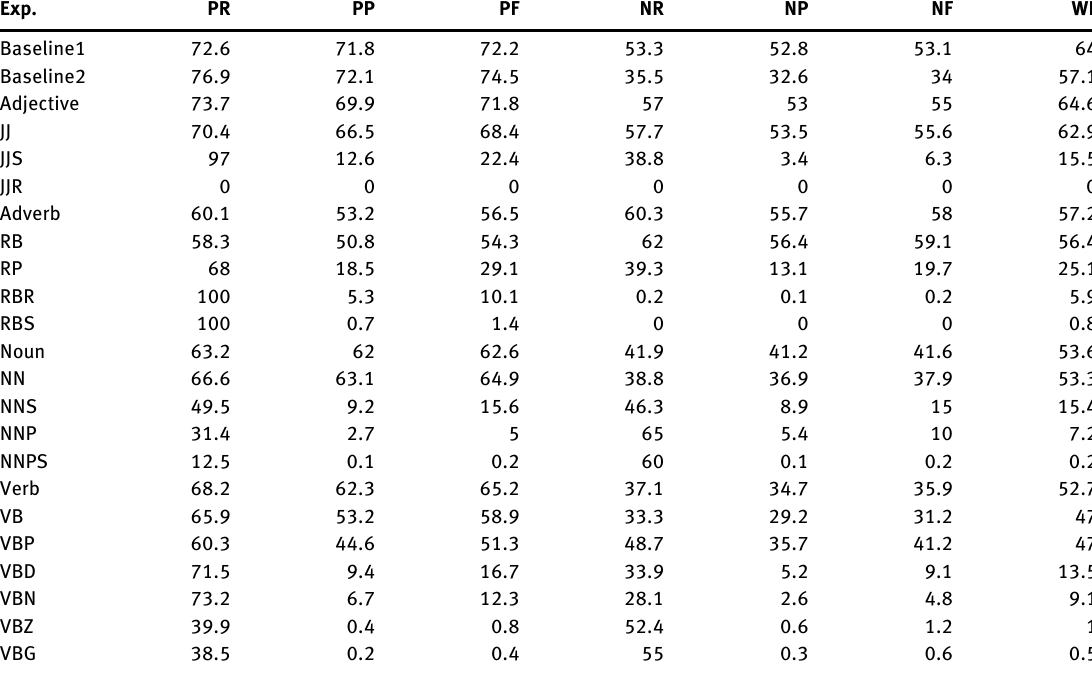
Table 4: Experimental Results for POS